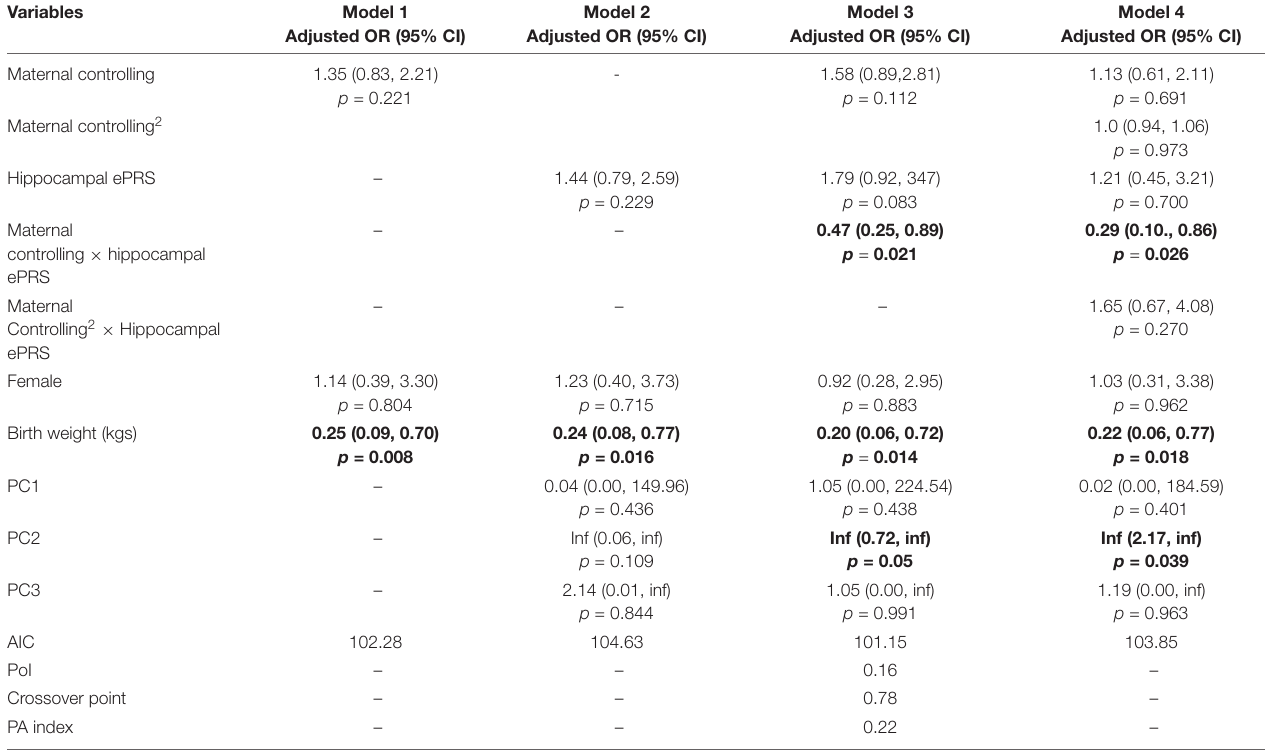
TABLE 4 | Associations among maternal controlling, hippocampal gene network for ePRS, covariates, and disorganized versus organized attachment pattern.